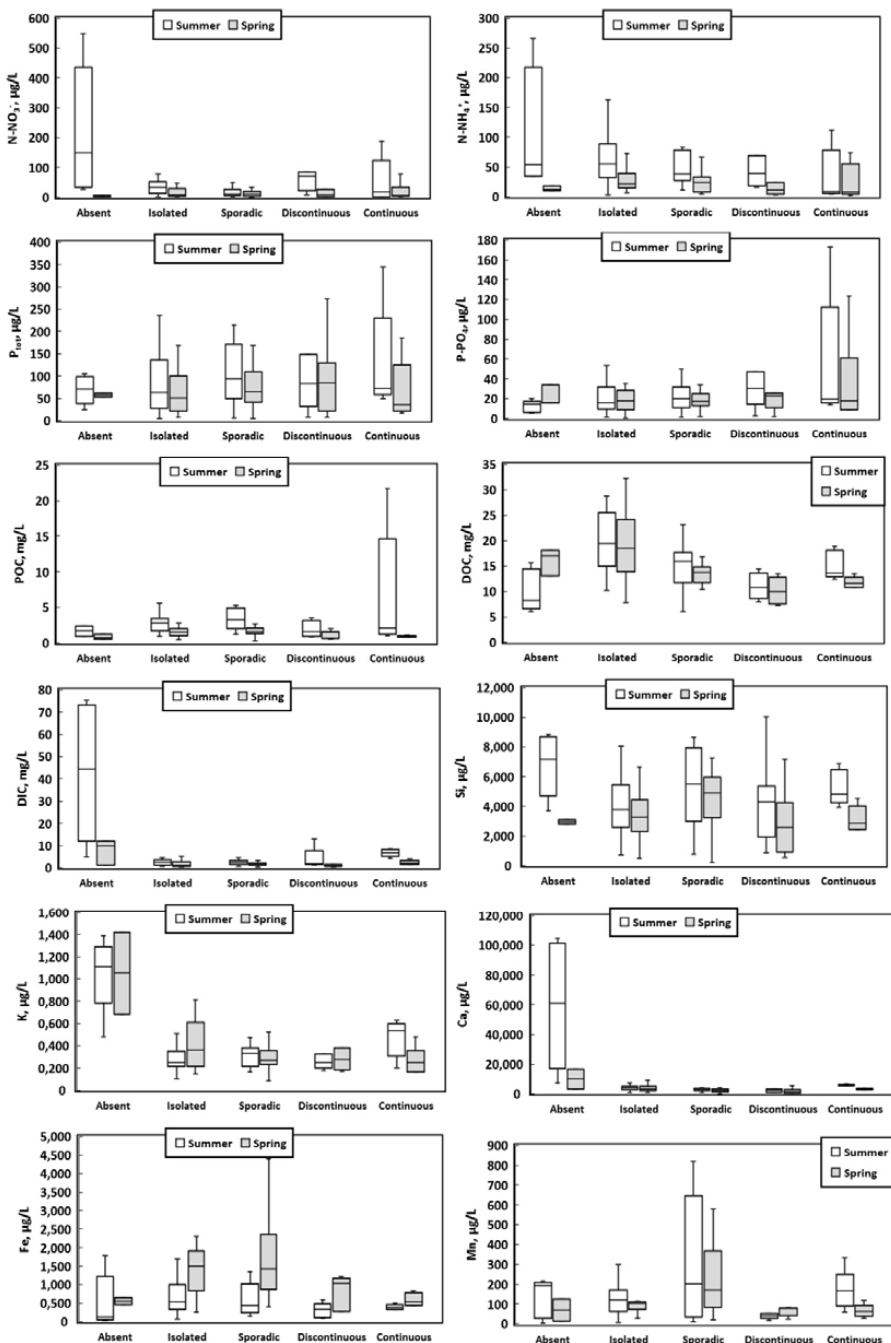
Figure 2. Box plot of first and third quartiles (25% and 75%) of nutrient concentrations in five permafrost zones during August (white rectangles) and June (grey rectangles). The horizontal line represents the median and the whiskers represent the minimum and maximum value. The outliers are not shown.